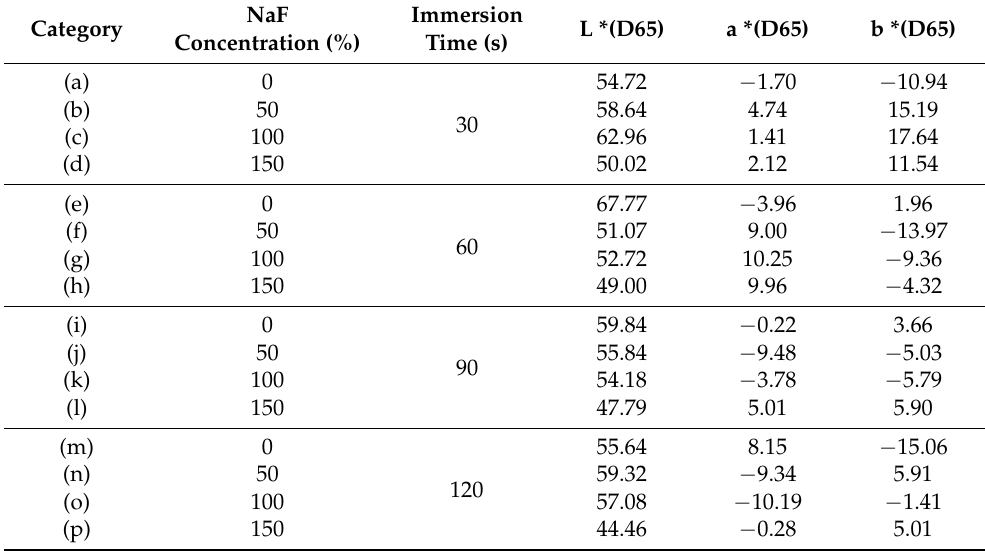
Table 1. SCE L *(D65), a *(D65), and b *(D65) values after chromium conversion treatment for different immersion times and NaF